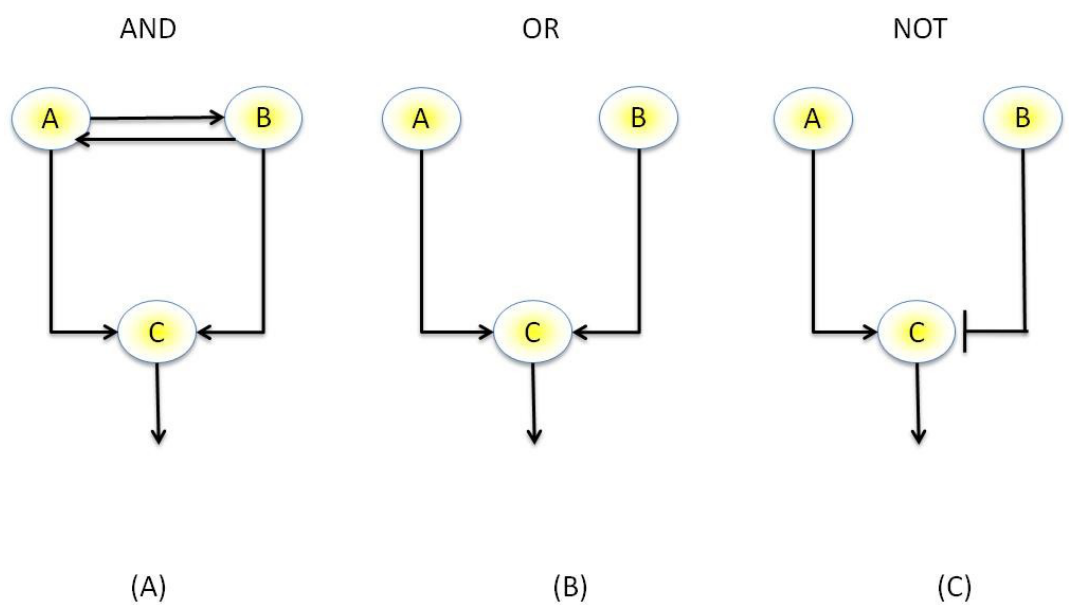
Figure 4. Example of a Boolean network. ( A ) AND motif: Genes A and B co-regulate each other, therefore Genes A and B must be active to activate Gene C ( B ) OR motif, either Gene A or B is sufficient to activate Gene C ( C ) NOT motif: Gene B down-regulates Gene C, therefore must be ―off‖ to allow activation of Gene